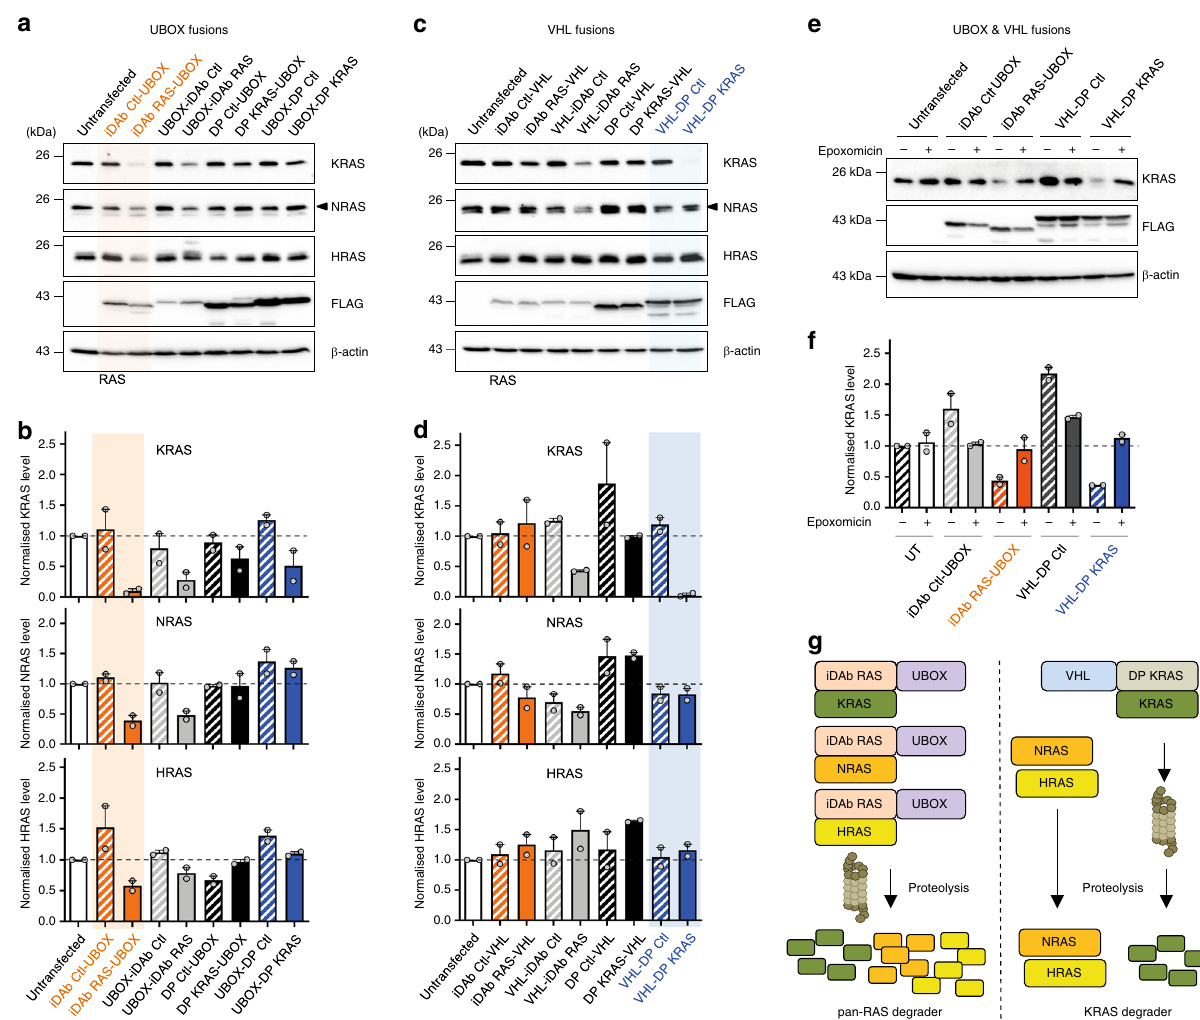
Fig. 1 Engineering KRAS and pan-RAS-targeted protein degradation with single domains. a Effect of the fusion single domain-UBOX on RAS proteolysis